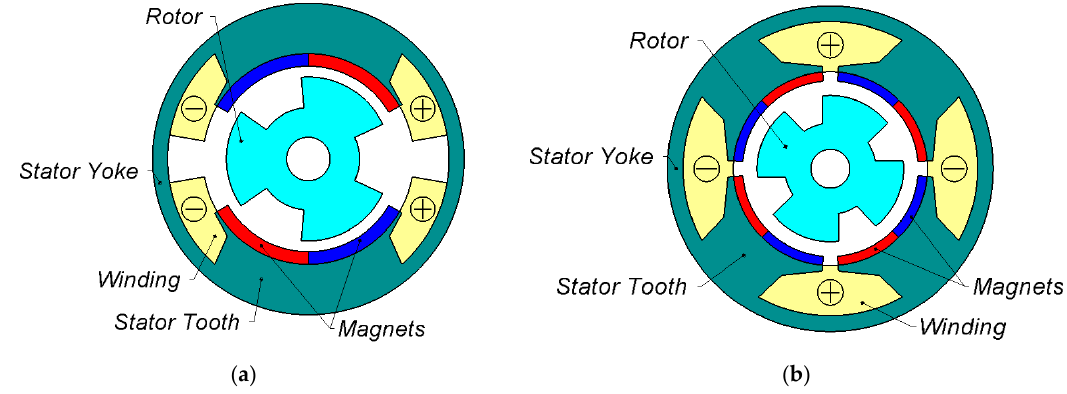
Figure 1. The Flux Reversal Machines (FRMs) geometry according to [1] ( a ), and according to [3] ( b ).